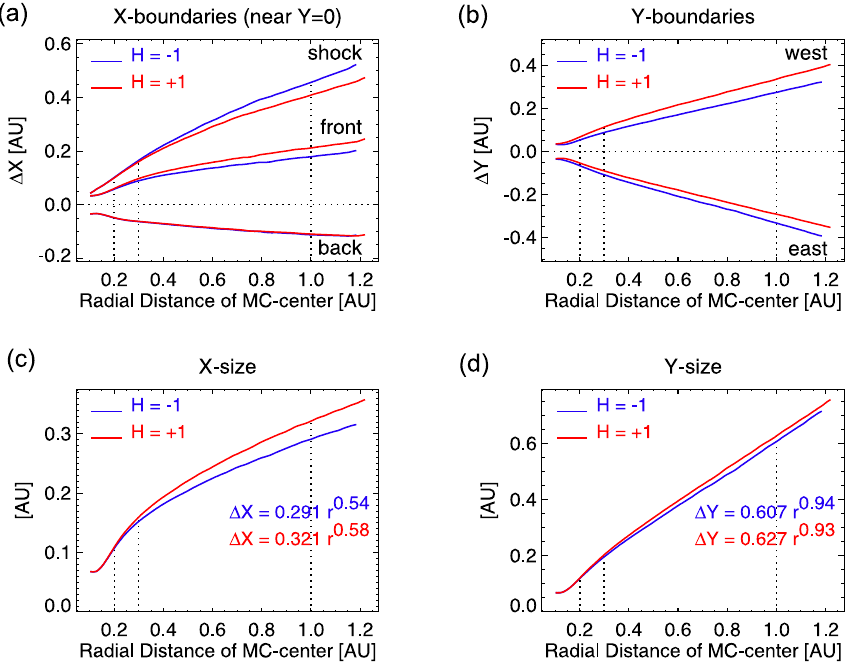
Fig. 8. Evolution of MC-boundaries and shock fronts as a function of radial distance to the Sun. In (a) the boundaries of H − e (blue) and H + e (red) with regard to x along y = Y MC − center are presented. The maximum extent into y-direction is presented in (b) . A comparison for the change of the clouds’ sizes in x- and y-directions is displayed in (c) and (d)